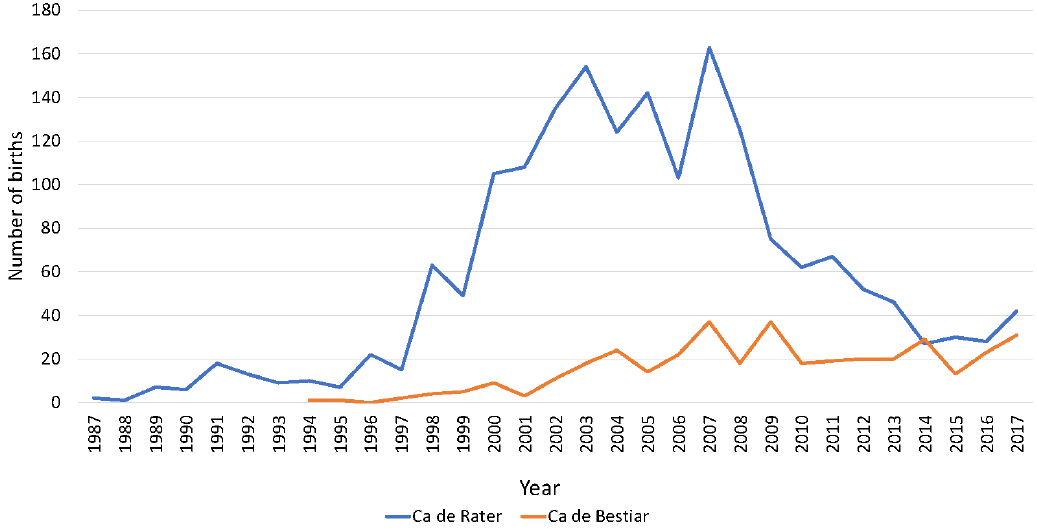
Figure 4. Birth number evolution from 1987 to 2018 for Ca de Rater and Ca de Bestiar dog breeds.